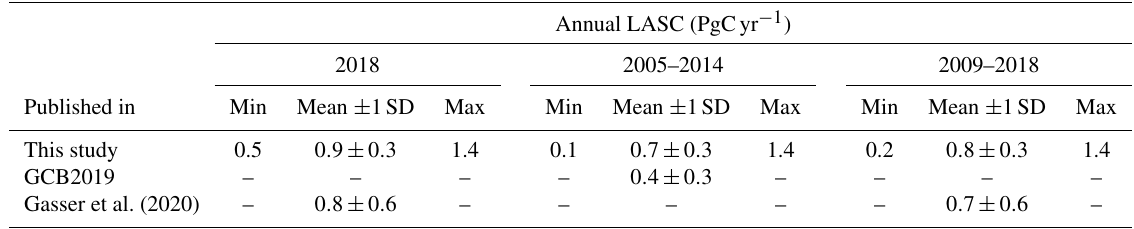
Table A2. Overview of global annual LASC estimates from this study (Friedlingstein et al. (2019) (GCB2019) and Gasser et al. (2020)). LASC estimates from GCB2019 and Gasser et al. (2020) are based on two different versions of OSCAR, which is constrained by DGVM estimates. Minimum, maximum, and mean with standard deviation refer to the model ensemble.